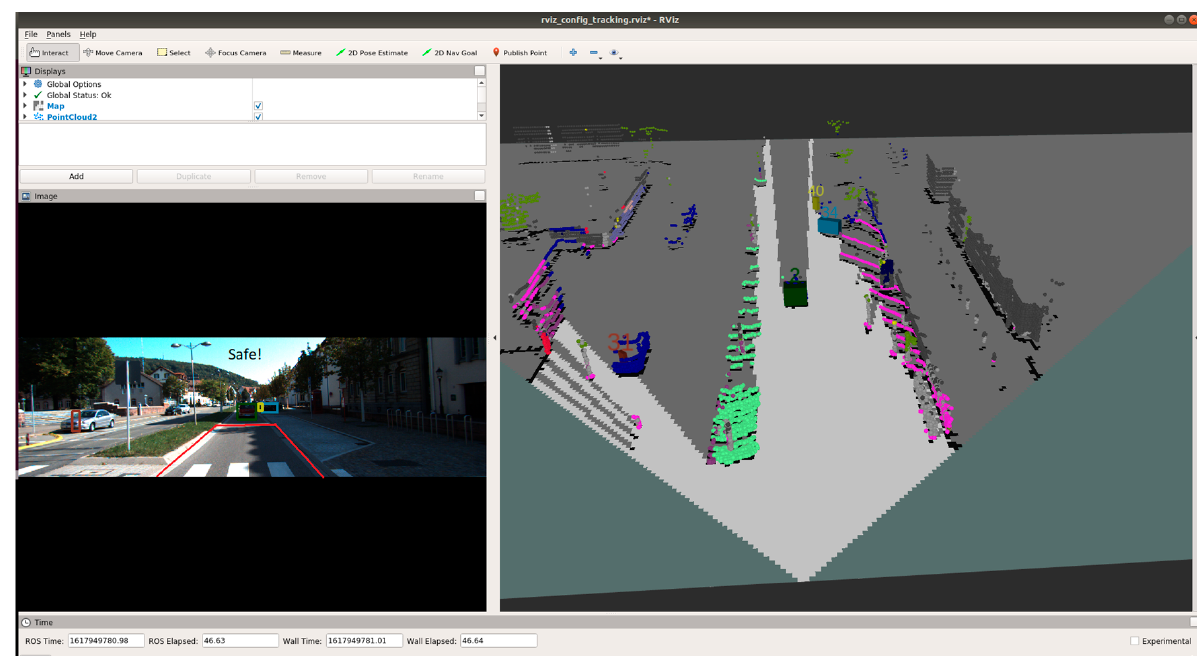
Figure 20. ‘ Safe’ scenario as detected by OCSF-driven EBA . Figure 20. ‘Safe’ scenario as detected by OCSF-driven EBA.